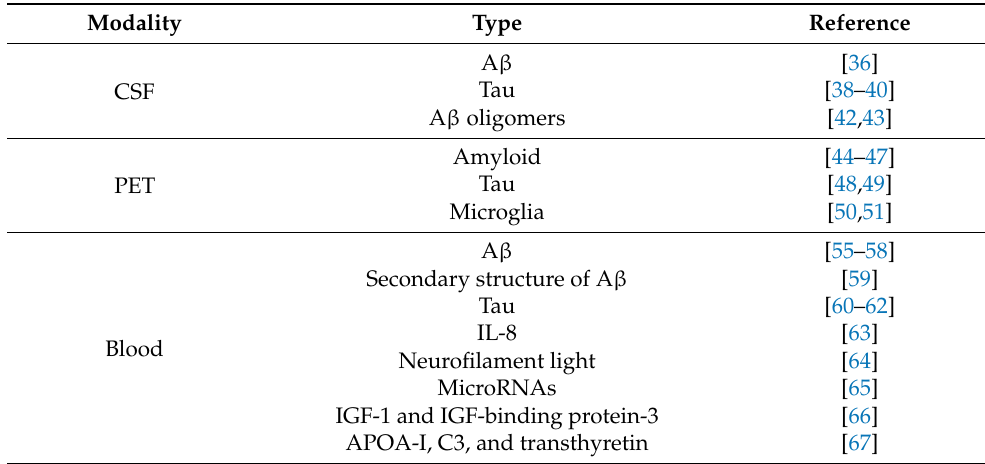
Table 1. Summary of representative biomarkers in